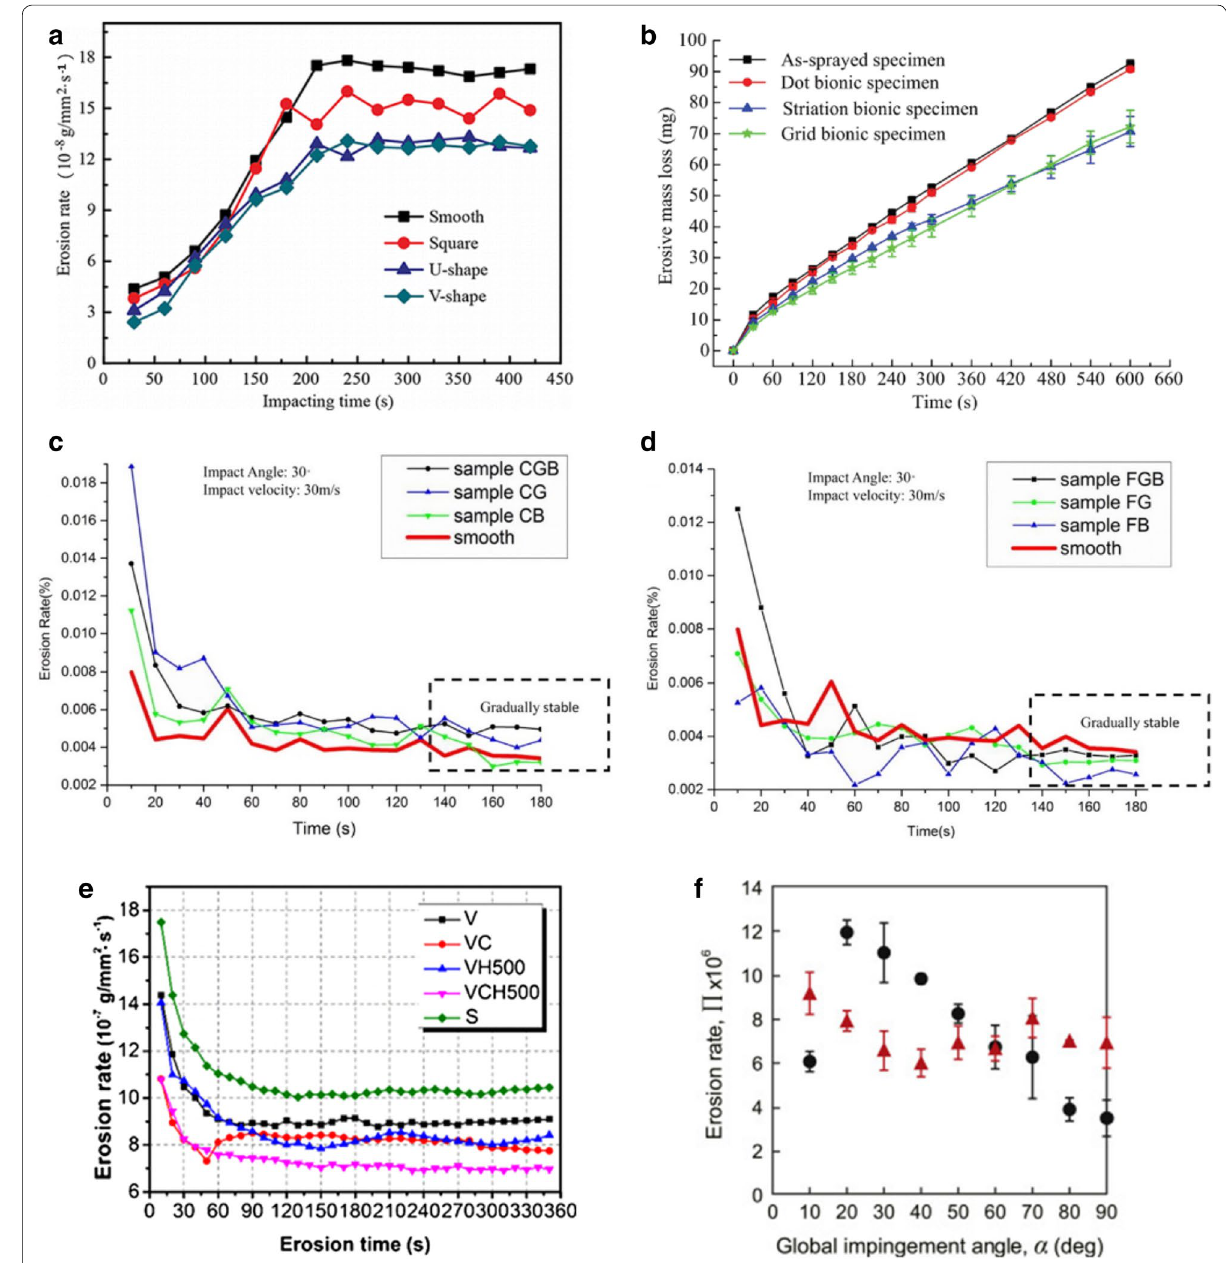
Figure 11 ( a ) The erosion rate of the groove samples with different shapes [61]; ( b ) The erosion rate of the pit samples with different arrangements [97]; ( c ) The erosion rate of the samples with composite structures, C stands for curve, G stands for groove, and B stands for bump [66]; ( d ) The erosion rate of the samples with composite structures, F stands for flat, G stands for groove, and B stands for bump [66]; ( e ) The erosion rate of the samples with composite structures, V stands for groove, C stands for convex hull (bump), H stands for hexagonal pit, S stands for smooth, and 500 stands for the size of a pit [19]; ( f ) The erosion rate of the groove samples and smooth samples at different impact angles